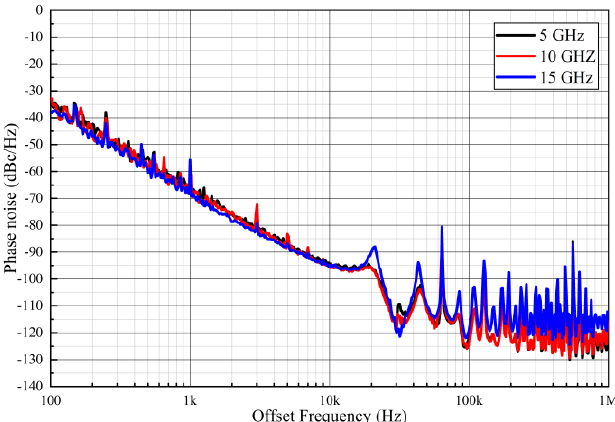
Figure 7. The 5, 10 and 15 GHz microwave signals phase noise of the coupled dual-loop SBS-based TOEO.